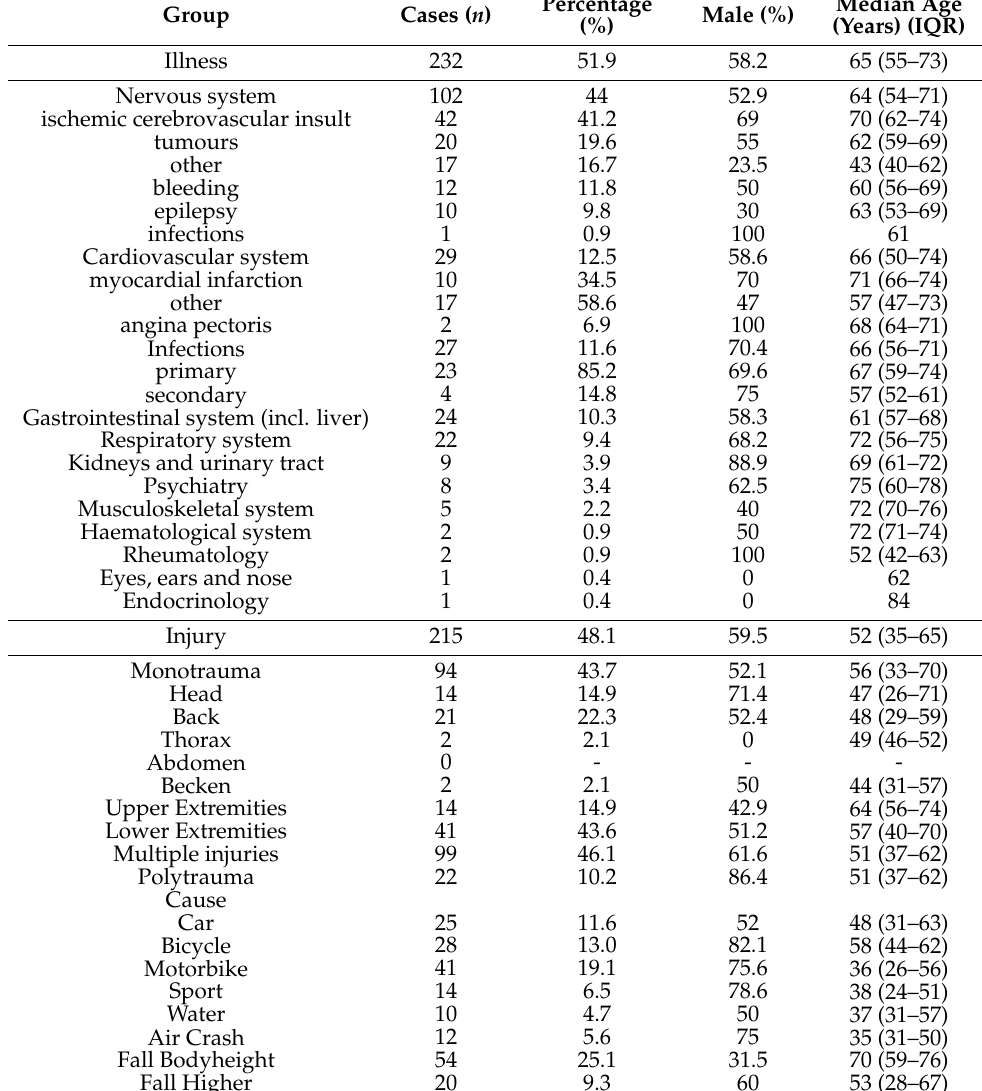
Table 3. Overview diagnoses and 30-day